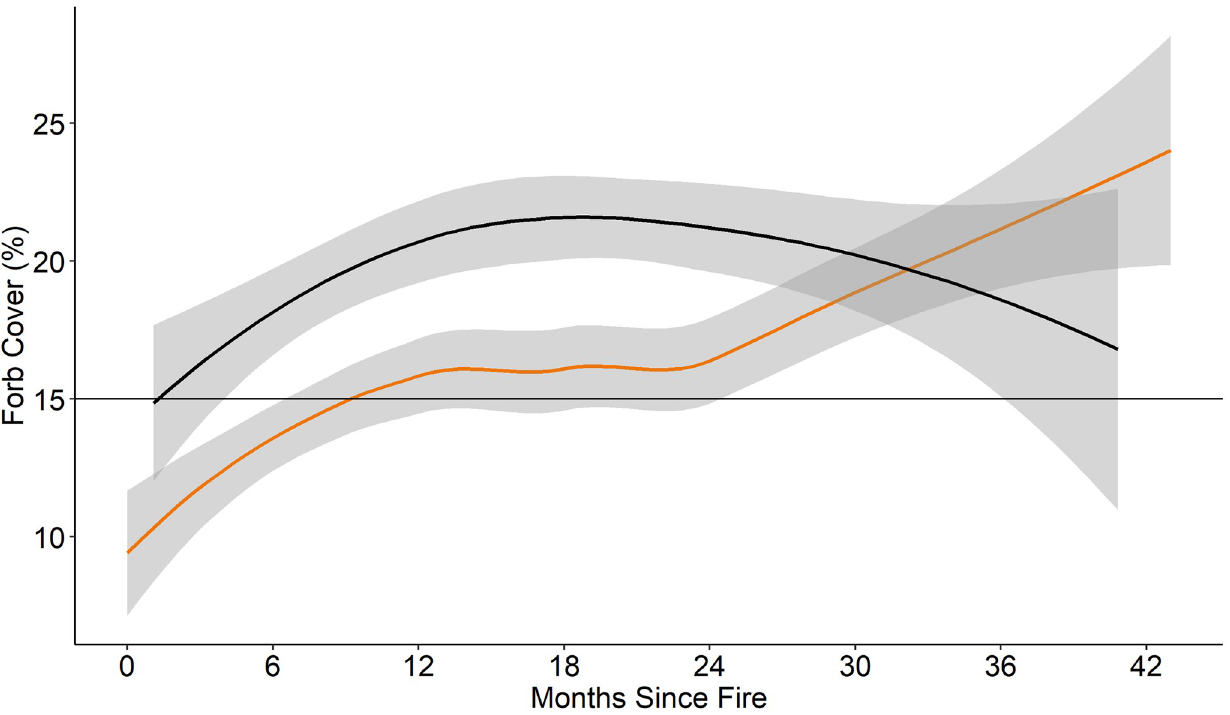
Fig 3. Percent forb cover. Percent forb cover for fire-only (orange) and pyric herbivory (black) treatments at all sites from 2014 to 2016. Shaded area indicates 95% confidence interval. Horizontal line represents minimum cover of forbs (15%) selected by females with broods as described in primary literature. � Regression lines and confidence intervals generated using “loess” locally-weighted smoothing